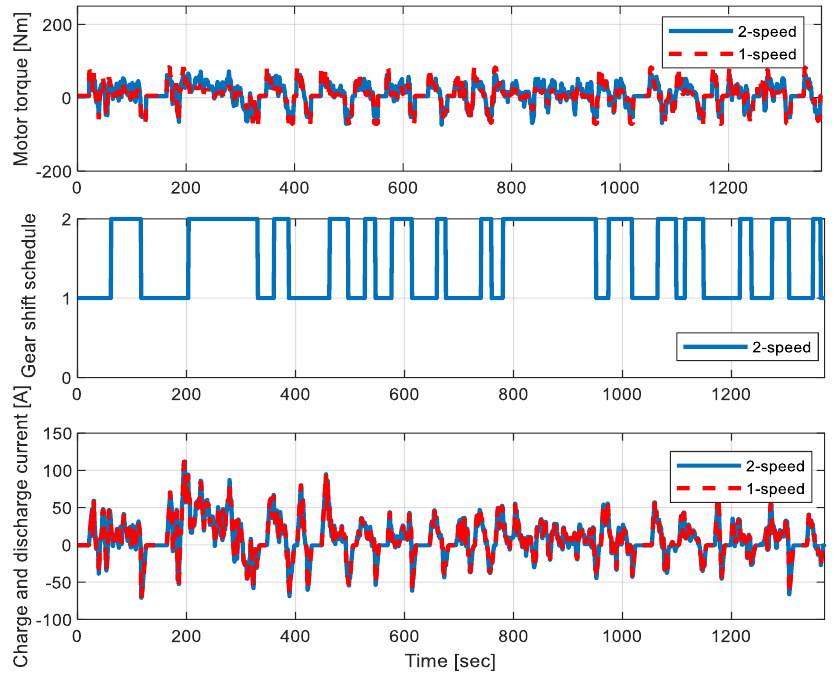
Figure 14. Comparison of system state trajectories of two gearboxes under UDDS cycle conditions.